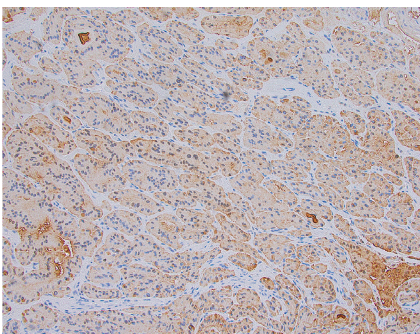
Figure 4: Positive cytoplasmic staining with thyroglobulin immunostain confirming the thyroid origin.